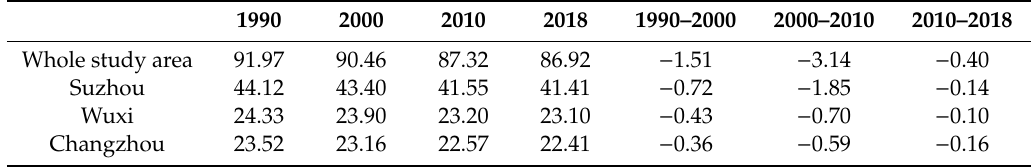
Table 7. Quantitative changes in carbon storage during 1990–2018 (Tg